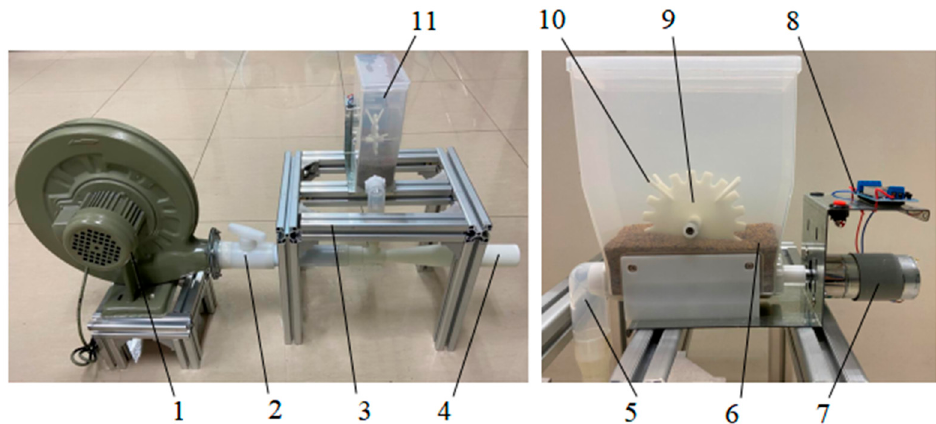
Figure 11. Coupled model validation test bench: 1. Fan. 2. Air valve. 3. Rack. 4. Venturi. 5. Seed drop.